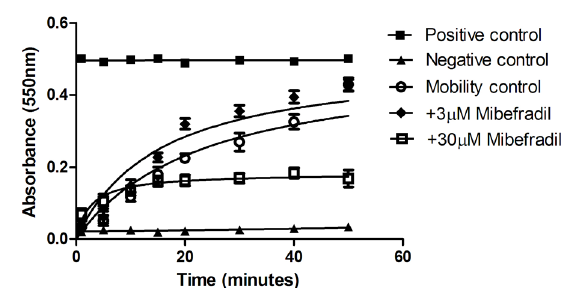
Figure 4. Progesterone accelerates the mobility of capacitated boar sperm. Under control conditions sperm penetrate the Accudenz solution with a Km = 19.2 ± 3.0 min (mobility control, 16 replicates). Sperm penetrate at a significantly (P=0.03) enhanced rate through the Accudenz solution containing 100nM progesterone (+100nM progesterone; Km = 9.5 ± 1.0 min, 20 replicates). Data sets are analysed as described in methods and results and are an average of 4 ejaculates from different boars with pooled replicates as indicated. Positive and negative control data sets are an average of 4 ejaculates measured in quadruplicate.